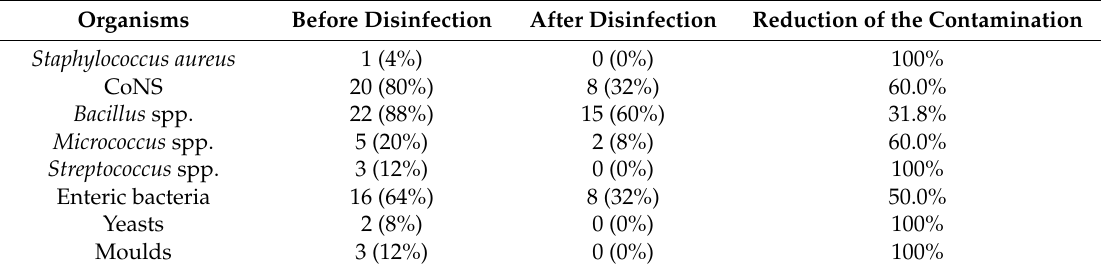
Table 2. Percentage evaluation of microorganisms isolated from computer keyboard surfaces ( n = 25) before and after disinfection and reduction of